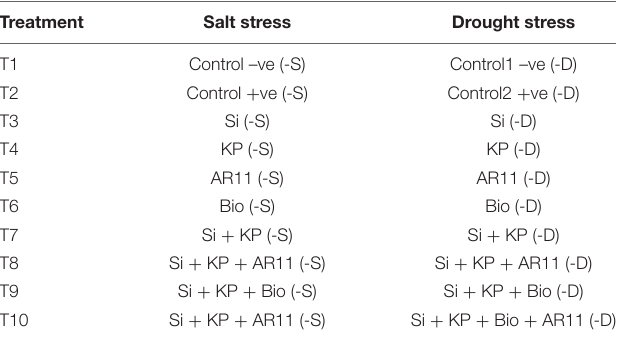
TABLE 1 | Outline of the experimental design for the independent experiment conducted under salt and drought stress conditions. Treatment Salt stress Drought